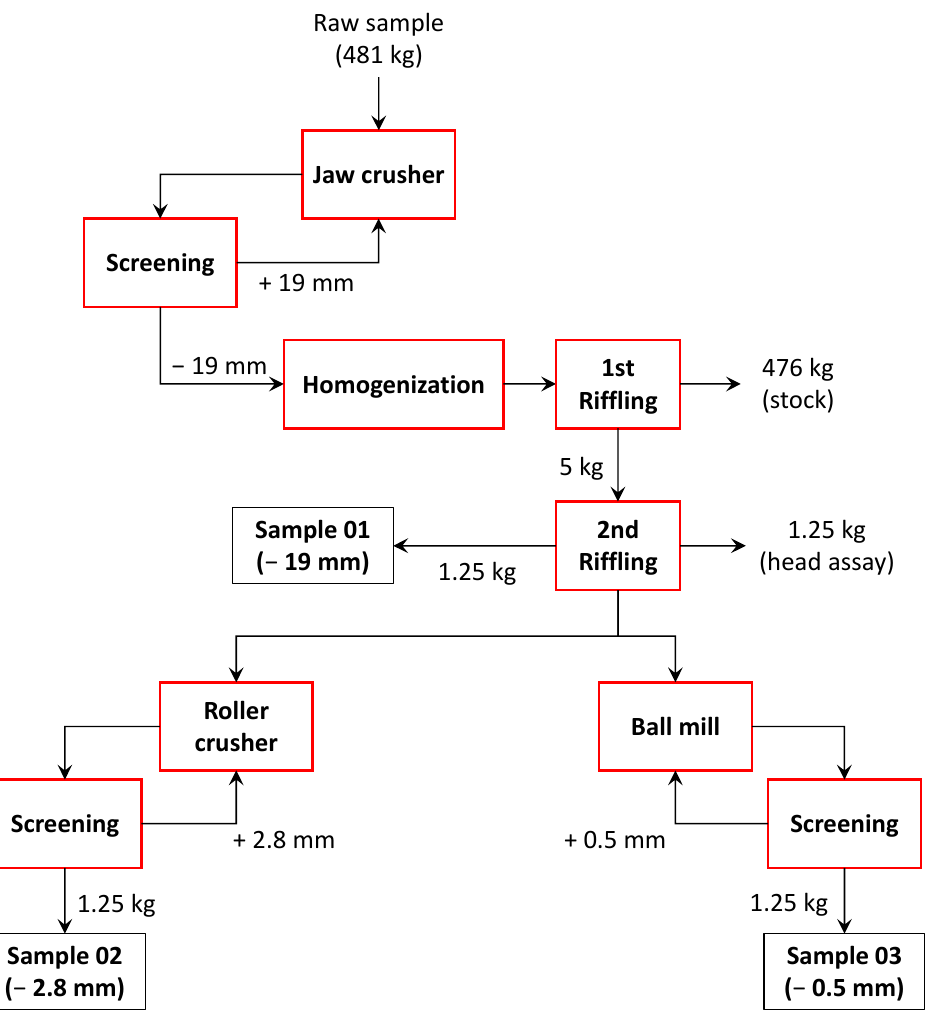
Figure 2. Subsample preparation scheme.